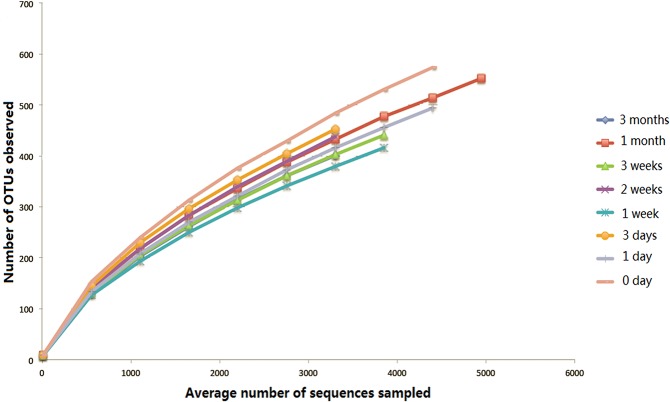
The rarefaction curves for different time intervals.The relationship between the number of OTUs observed and the average number of sequences sampled over eight sampling times (day 0, 1 day, 3 days, 1 week, 2 weeks, 3 weeks, 1 month and 3 months) are profiled by the rarefaction curves (0.03 dissimilarity level).